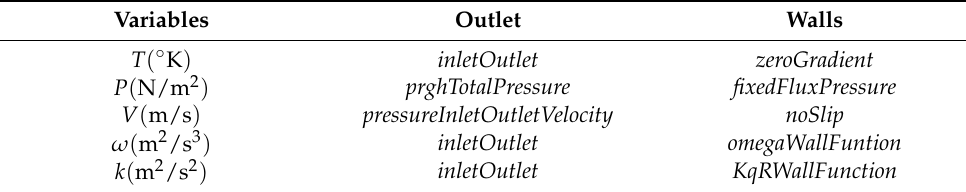
Table 4. Boundary conditions for the variables of the turbulent